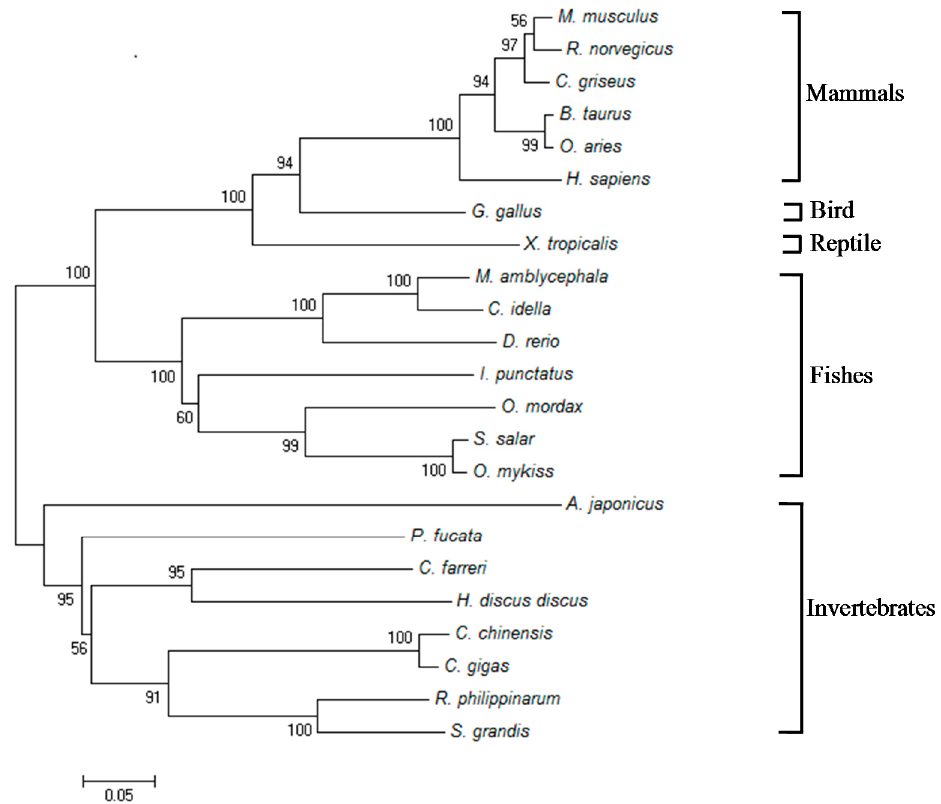
Figure 3. The neighbor-joining phylogenetic tree of MaLITAF protein and other known homologues from GenBank registered. The numbers at the nodes represent bootstrap values for 1000 replications and the bar (0.1) indicates genetic distance. The sequences of LITAFs from other species were downloaded from GenBank: C . idella (ACT68335), Danio rerio (NP_001002184), Ictalurus punctatus (NP_001187935), Oncorhynchus mykiss (NP_001158593), Osmerus mordax (ACO09164), Salmo salar (ACI67257), Gallus gallus (NP_989598), Xenopus tropicalis (NP_988970), Mus musculus (NP_064364), Homo sapiens (NP_004853), Bos taurus (NP_001039717), Cricetulus griseus (XP_003496739), Ovis aries (XP_004020821), Rattus